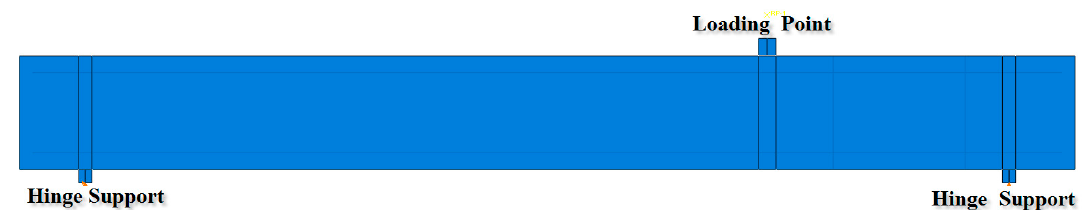
Figure 15. Proposed numerical model for concrete slabs.